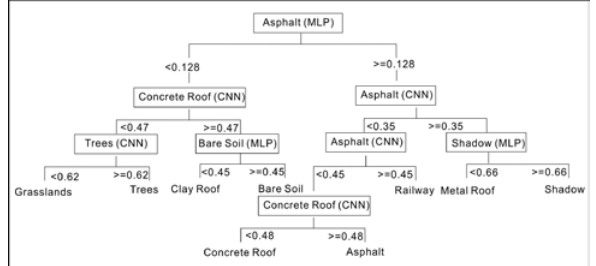
Figure 3. The decision tree of the MLP-CNN to derive the land cover classes at the uncertain